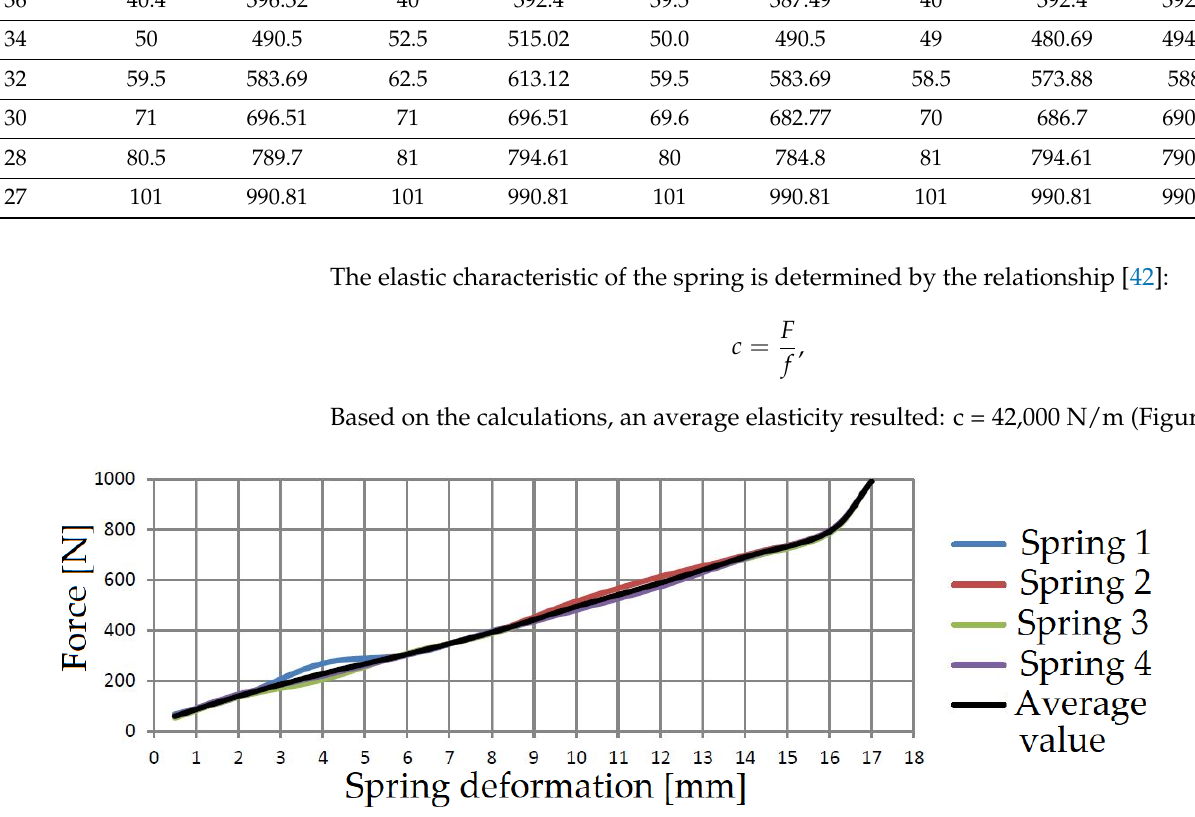
Figure 8. Elastic characteristic of the valve spring.